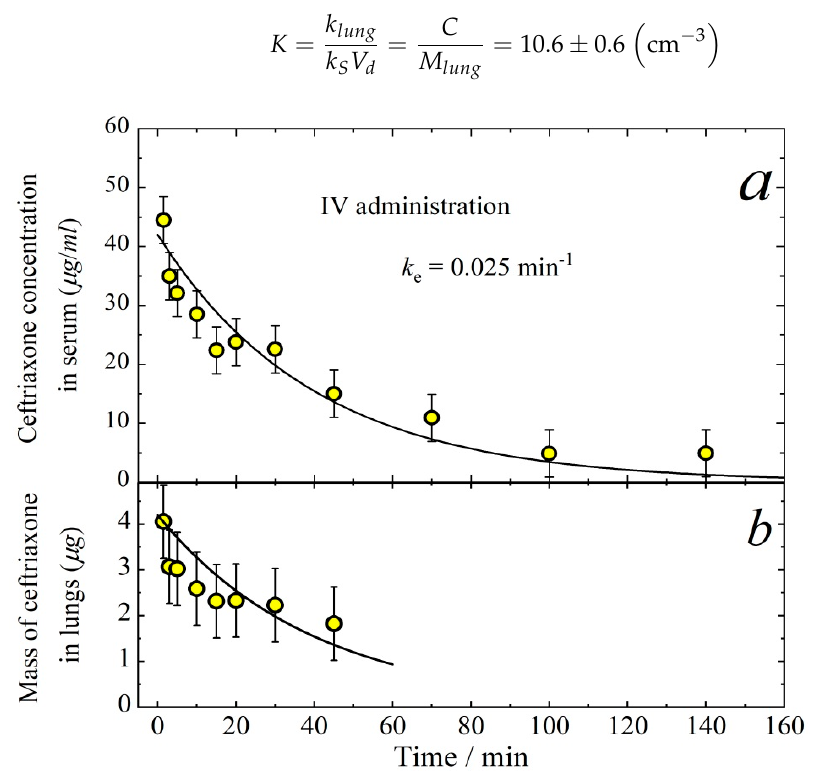
Figure 6. Temporal dependence of the concentration of ceftriaxone in serum ( a ) and the mass of ceftriaxone in lungs ( b ) after intravenous injection with the dose of 5 mg/kg. Solid lines follow the exponential decay ~exp( − 0.025(min − 1 ) · time). The time interval for the data points in panel ( b ) is limited to 50 min because at longer times the experimental error is too high with respect to the signal intensity.